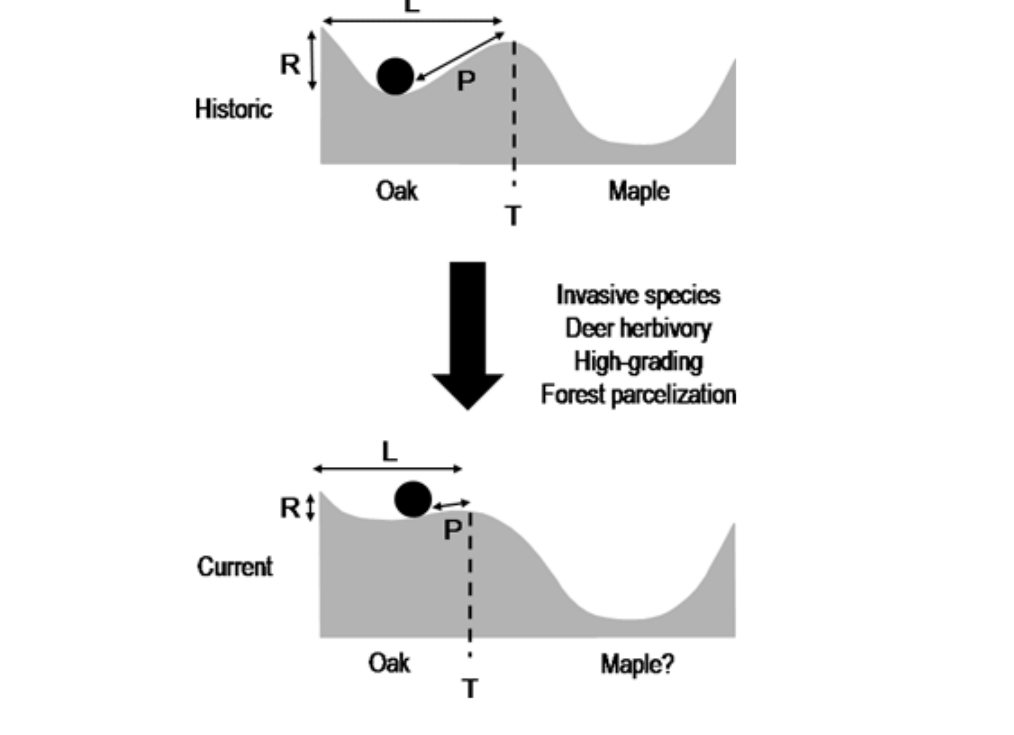
Fig. 4 . The stability domains and landscape of the historic and current forest landscape in the Driftless Area of the Midwest, as portrayed through a ball and cup heuristic (adapted from Nowacki and Abrams 2008). The state of the system is the ball and the stability domains are represented as the cups (i.e., oak and maple). The stability landscape is composed of one or more domains. The transition between domains occurs where the conditions in the system reach a critical level or the system threshold (T). Overall system resilience, or ability of the system to retain the same structure and function, is influenced by: system resistance (R) to change; system latitude (L), or the maximum amount that the system can change before reaching a threshold, or system latitude; and the precariousness (P), or nearness to a threshold. The current oak system has decreased overall resilience to change because of a combination of ecological, economic, and social drivers, with a potential shift to a stability landscape dominated by maple or uncertain and novel stability